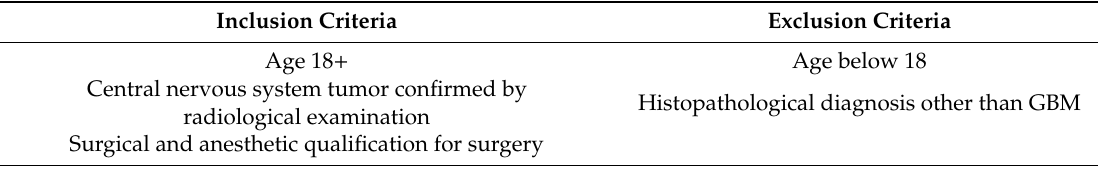
Table 2. Inclusion and exclusion criteria. GBM: glioblastoma multiforme.